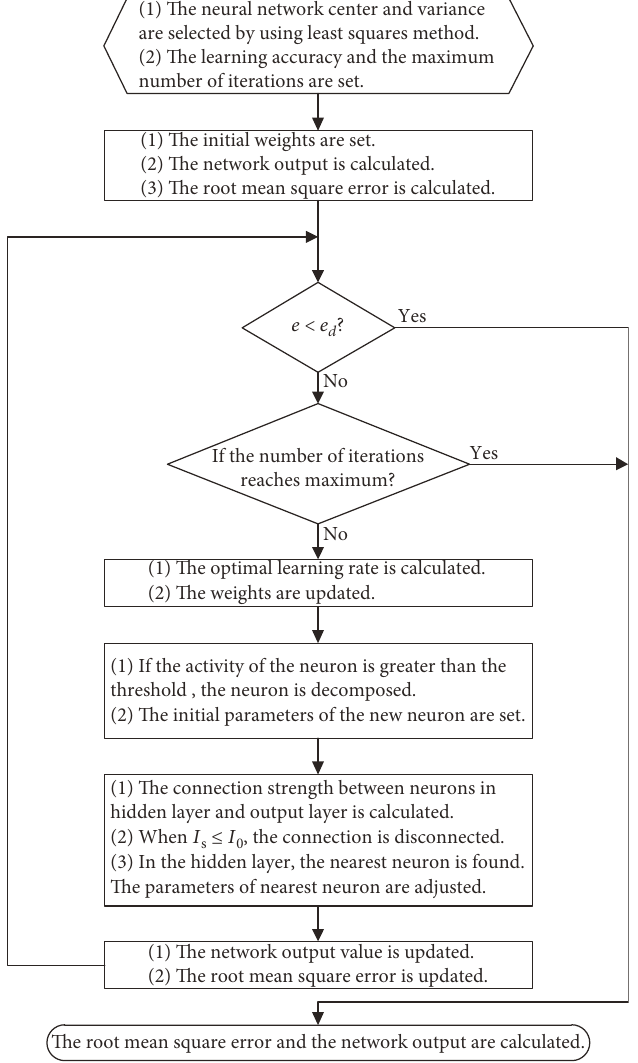
Figure 5: Learning algorithm of VS-RBF with the fast learning